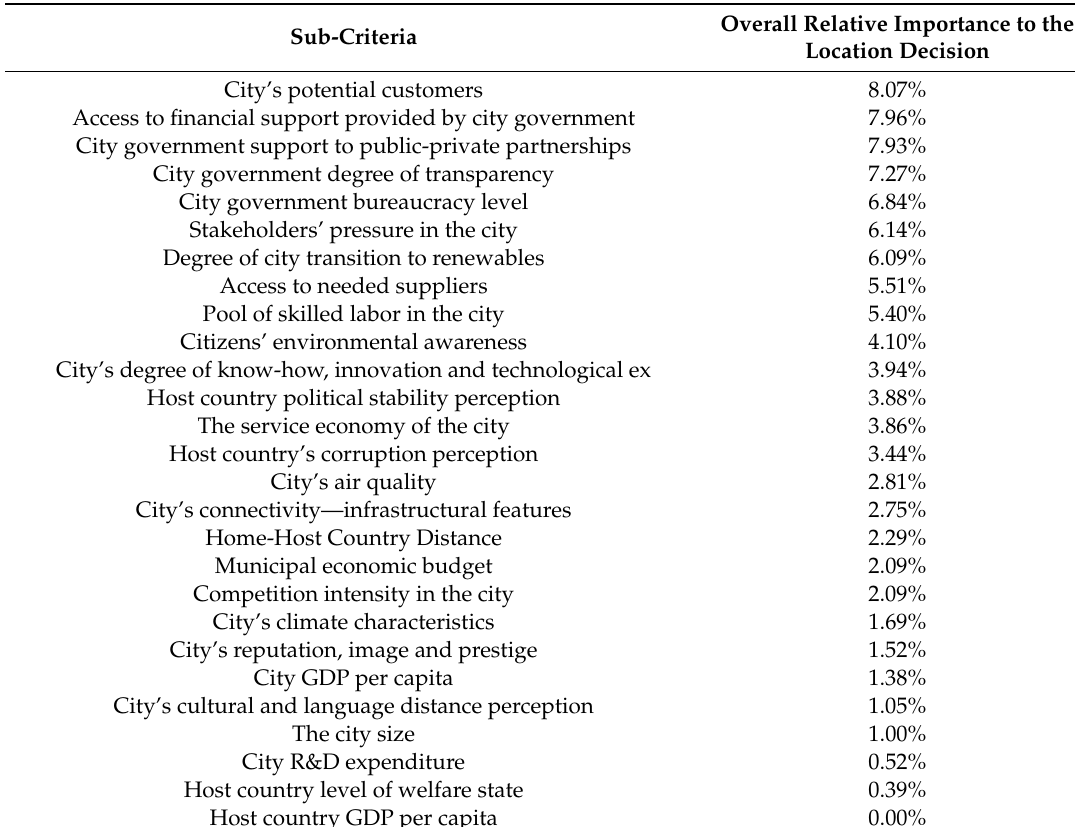
Table 13. Sub-criteria overall